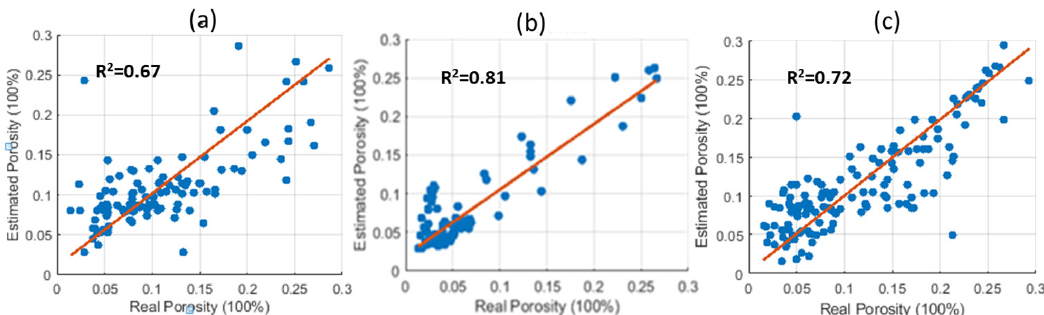
Figure 13. Cross ‐ plots of estimate and real porosity log for ( a ) Well ‐ 3 (blind), ( b ) Well ‐ 1 (control), Figure 13. Cross-plots of estimate and real porosity log for ( a ) Well-3 (blind), ( b ) Well-1 (control), and and ( c ) Well ‐ 2 (blind). Red lines are the best fi t line between the real and estimated porosity. ( c ) Well-2 (blind). Red lines are the best fit line between the real and estimated porosity.